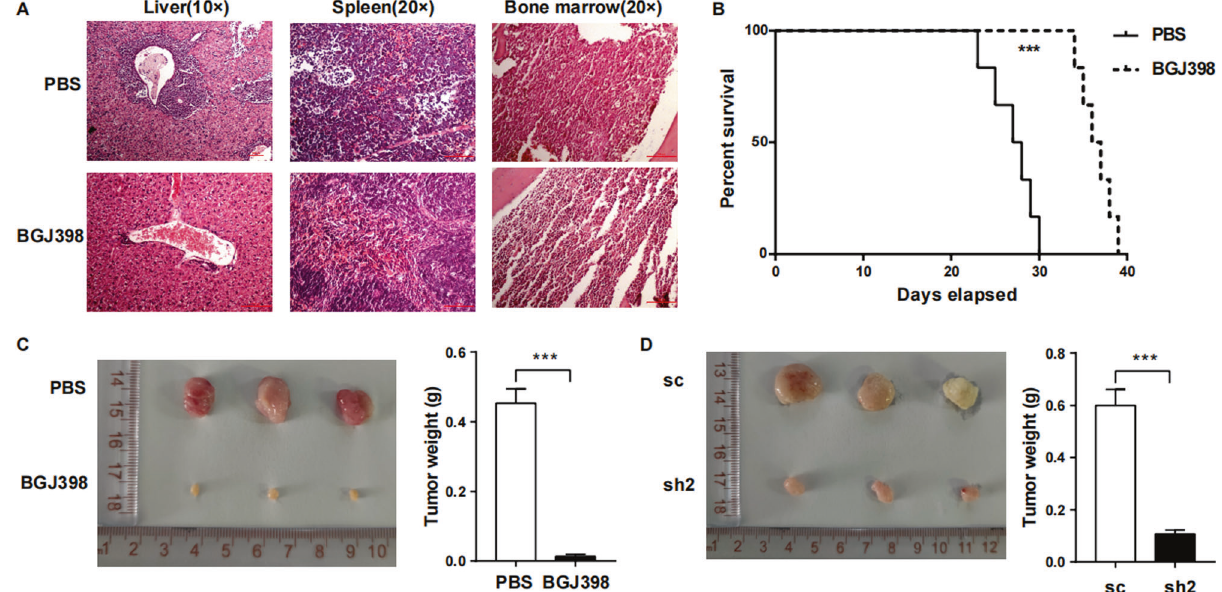
Fig. 7 The survival of T-ALL was signi fi cantly prolonged after FGF2/FGFR2 blockade in vivo. A On day 14 after model establishment, the mice were killed. Biopsy of liver, spleen and BM of leukaemia mice stained with hematoxylin-eosin (H & E) revealed that in fi ltration of leukaemia cells to these organs were decreased after BGJ398 treatment. B The survival curve indicated that prolonged survival was observed in FGF2/FGFR2 blockade mice. ( n = 6) C Subcutaneous tumour formation assay revealed that the tumour size and weight in BGJ398 group on day 30 after model establishment were smaller compared to PBS group. D Knockdown of FGF2 in HS-5 also signi fi cantly inhibited subcutaneous tumour growth compared to control group on day 30 after model establishment. ( n = 3, *** P < 0.005). Cell Death and Disease (2022)